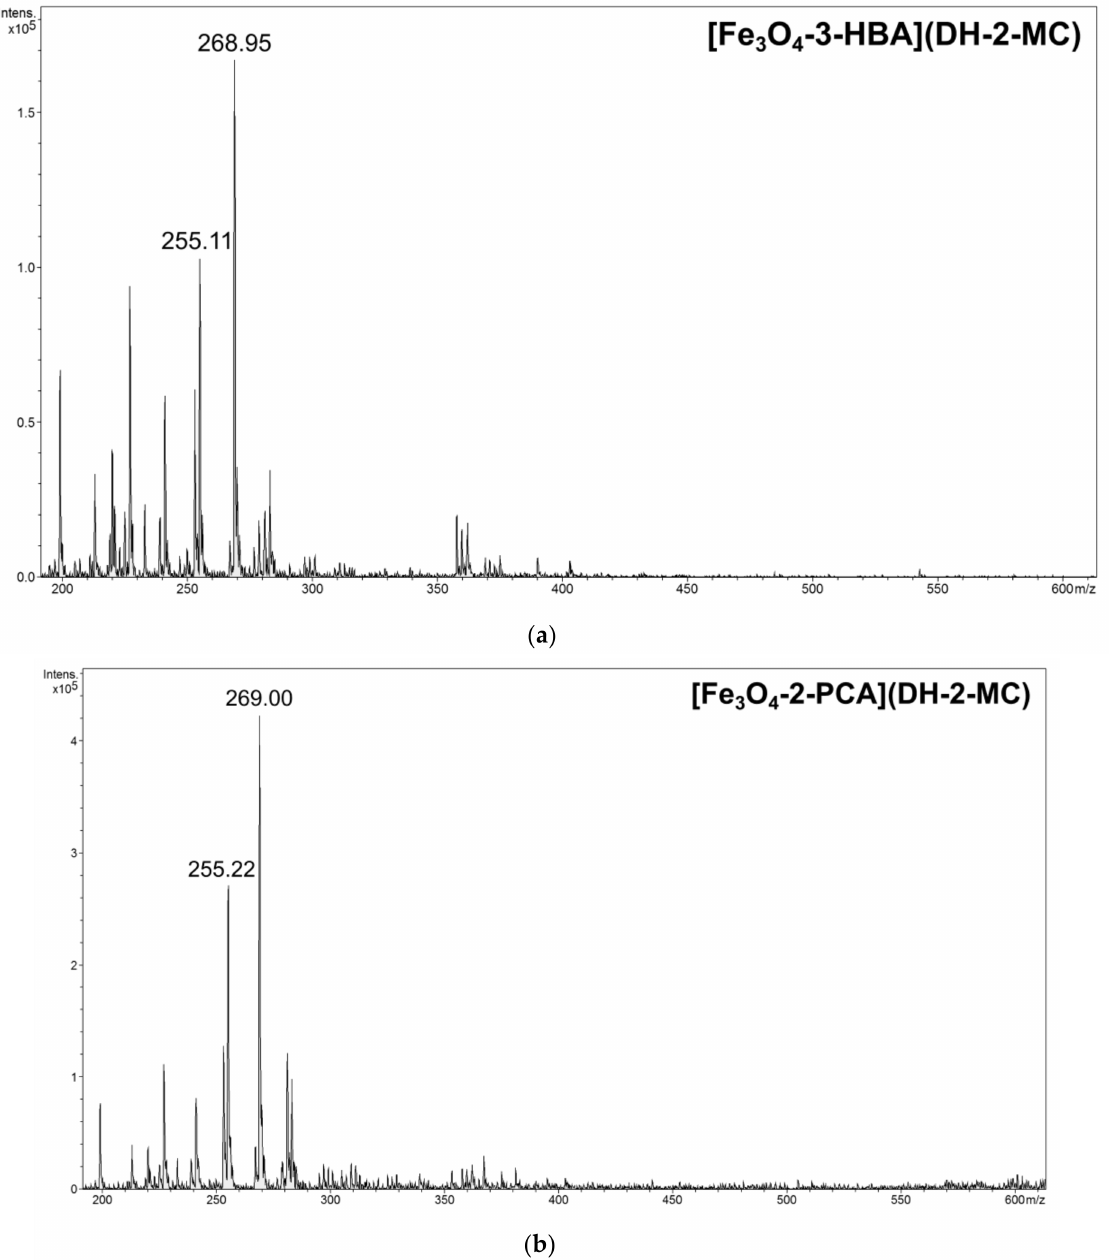
Figure 7. Exemplary FAPA-MS spectra of DH-2-MC thermally desorbed from 50 mg samples of its complexes with ( a ) Fe 3 O 4 -3-HBA and ( b ) Fe 3 O 4